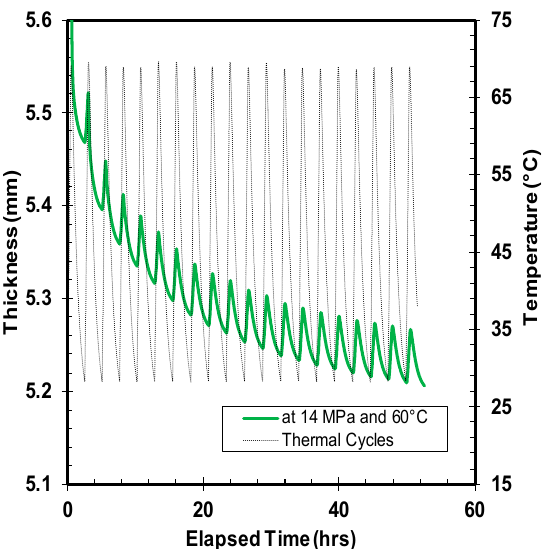
Figure 7. Thickness variation of high density polyethylene (HDPE) under 14 MPa of stress and a thermal ratcheting temperature range of 28 to 60 °C.